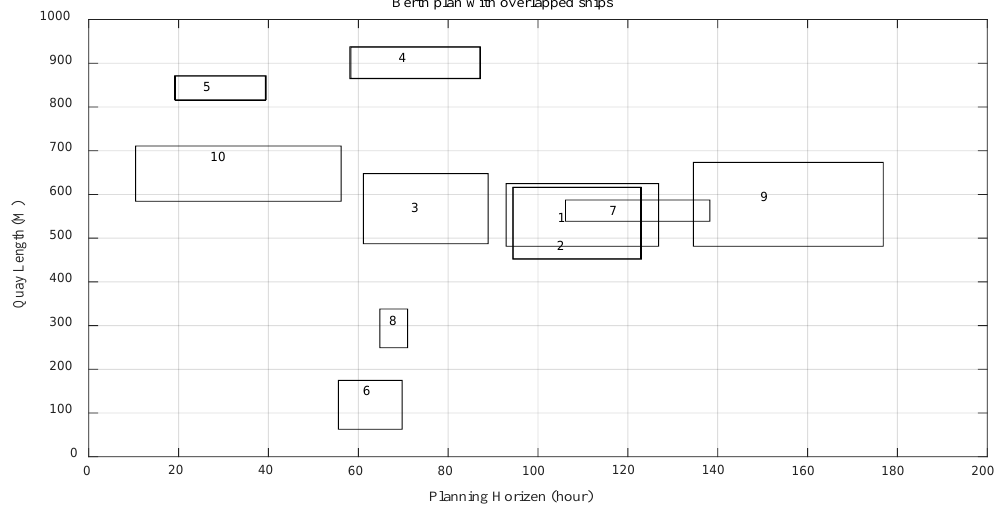
= 10 ships). Appl. Sci. 2019 , 9 , x FOR PEER REVIEW